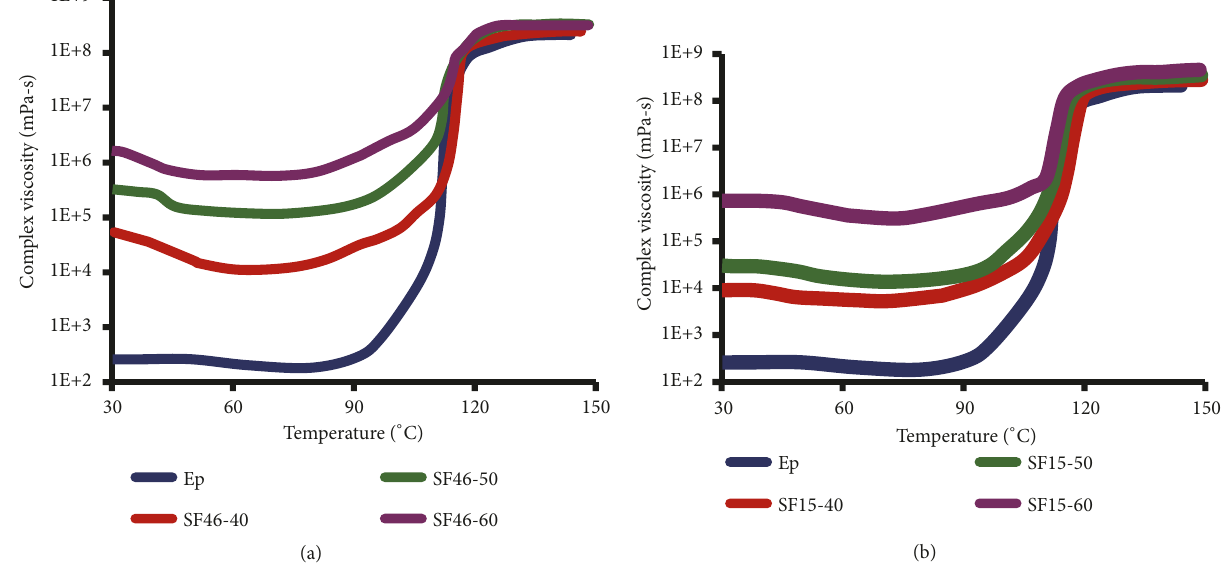
Figure 3: The effect of increasing microballoon loading on complex viscosity: (a) K46-epoxy formulations and (b) K15-epoxy formulations.